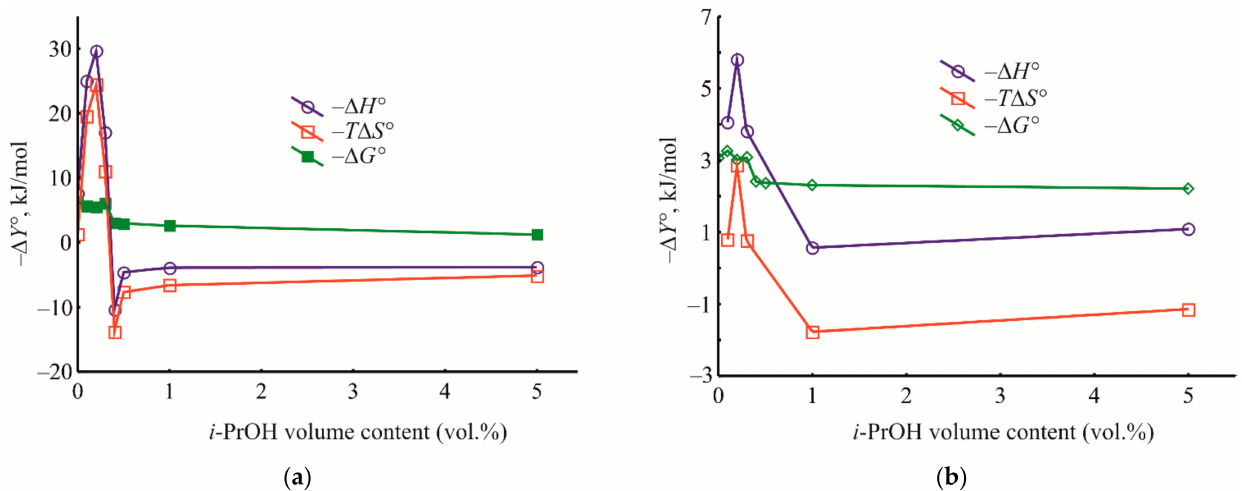
Figure 13. Dependences of the thermodynamic characteristics of benzene adsorption onto the pristine HKUST-1 ( a ) and bare BPS ( b ) samples on the i -PrOH content (vol.%) in the mobile